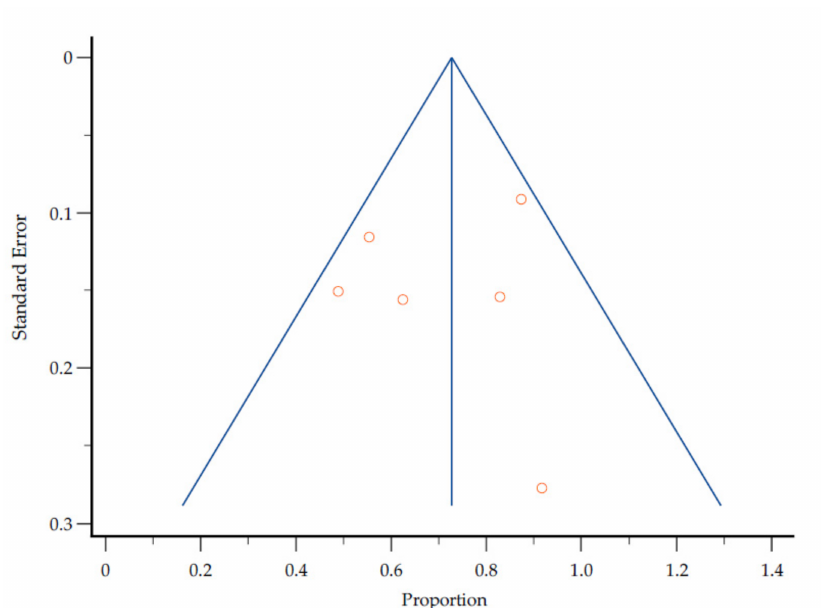
Figure 3. Assessment of publication bias by a funnel plot of the proportion of malnutrition estimates against corresponding standard